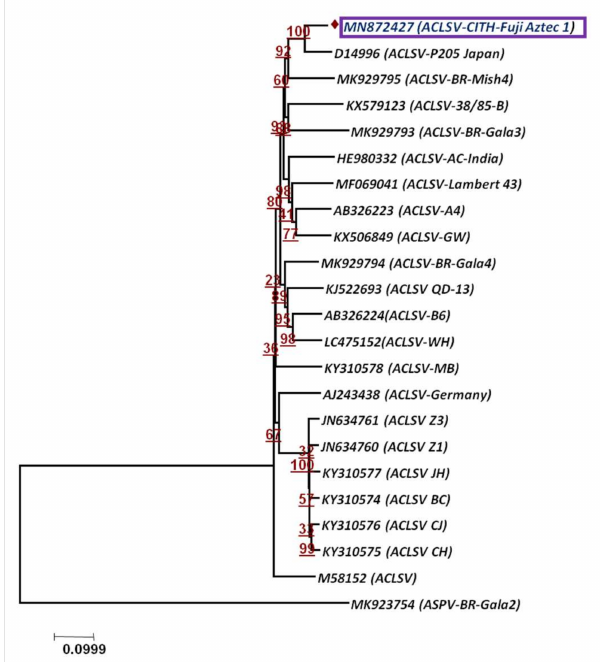
Figure 8. Phylogenetic relationship of Apple chlorotic leaf spot virus based on whole-genome se- quence alignment through NJM at 1000 replications for each bootstrap value using MEGA 7.0; our ACLSV isolate is highlighted with color in phylogeny. Apple stem pitting virus (ASPV) represents out-group.